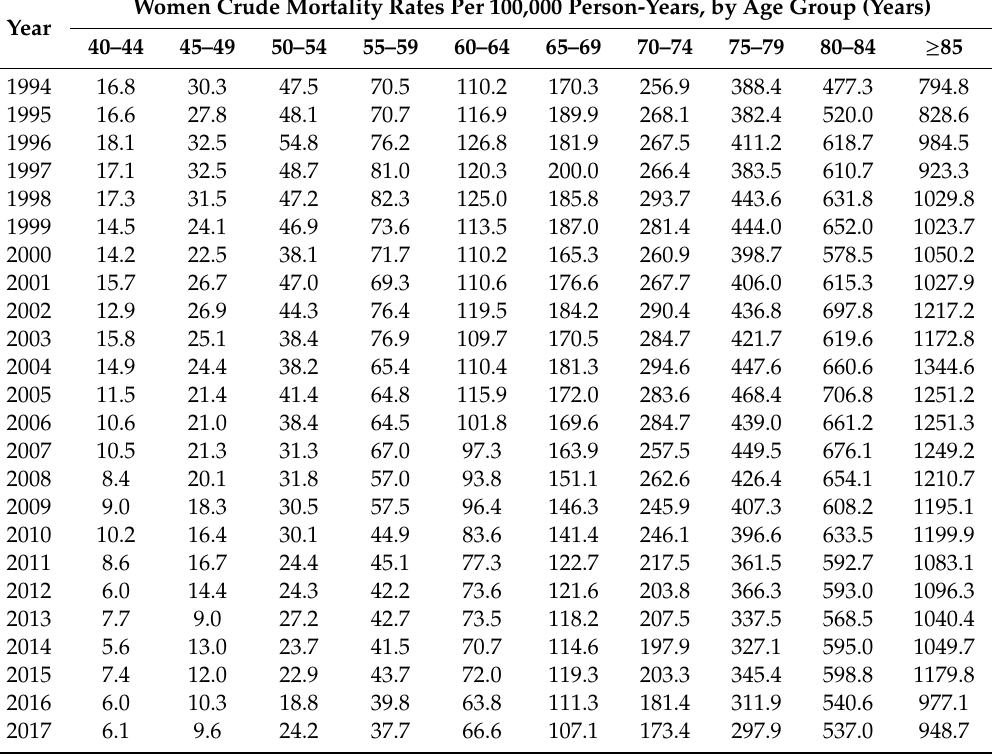
Table A1. Acute myocardial infarction crude mortality rates in women, by age and calendar year. Year